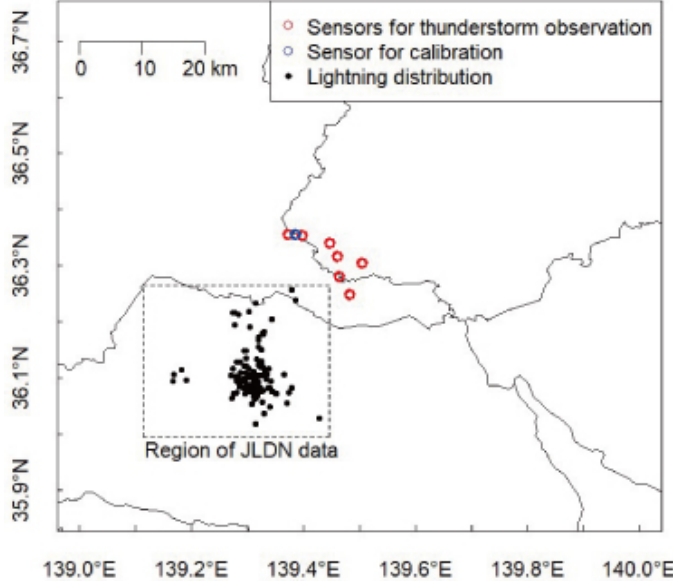
Figure 6. Distribution of the EFM systems running during oncoming thunderclouds on 27 August 2020. Blue circles are the location of a station for calibration. Black dots indicate the spatial distribu- tion of lightning discharges obtained by the Japanese Lightning Detection Network (JLDN) during 0:40–1:40 (LT) on 27 August 2020.